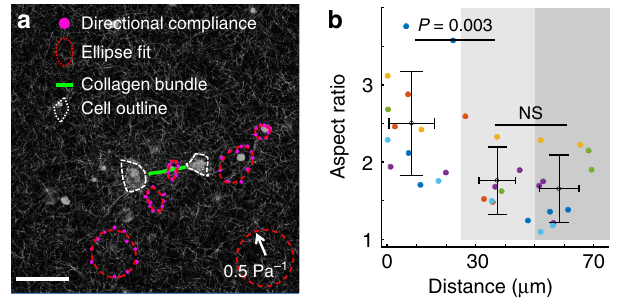
Fig. 4 The micromechanics of collagen ECM in the vicinity of cell-induced collagen bundles after traction forces are released. a The confocal re fl ection image and directional compliance given by fi ve probe particles around a collagen bundle in a typical experiment. The compliance is scaled linearly into real space such that an isotropic response of 0.5 Pa − 1 would be plotted as a ring with the size of the bottom right circle. Magenta dots: experimentally measured directional compliance. Red circles: the compliance ellipse, i.e., the elliptical fi t to the magenta dots. White dashed lines: outlines of MDA-MB-231 cells after Cytocytochalasin-D treatment. Green line: the location of collagen bundle. Scale bar: 50 μ m. b The aspect ratios of the compliance ellipses at varying particle-to-bundle distances d . Symbols of different colors correspond to results measured around different bundles. We divide all the data into three groups d < 25 μ m, 25 ≤ d < 50 μ m, and 50 ≤ d < 75 μ m. Error bars represent the mean and standard deviations of each group. ANOVA analysis shows that the aspect ratios close to the collagen bundles ( d < 25 μ m) are signi fi cantly higher than the values further